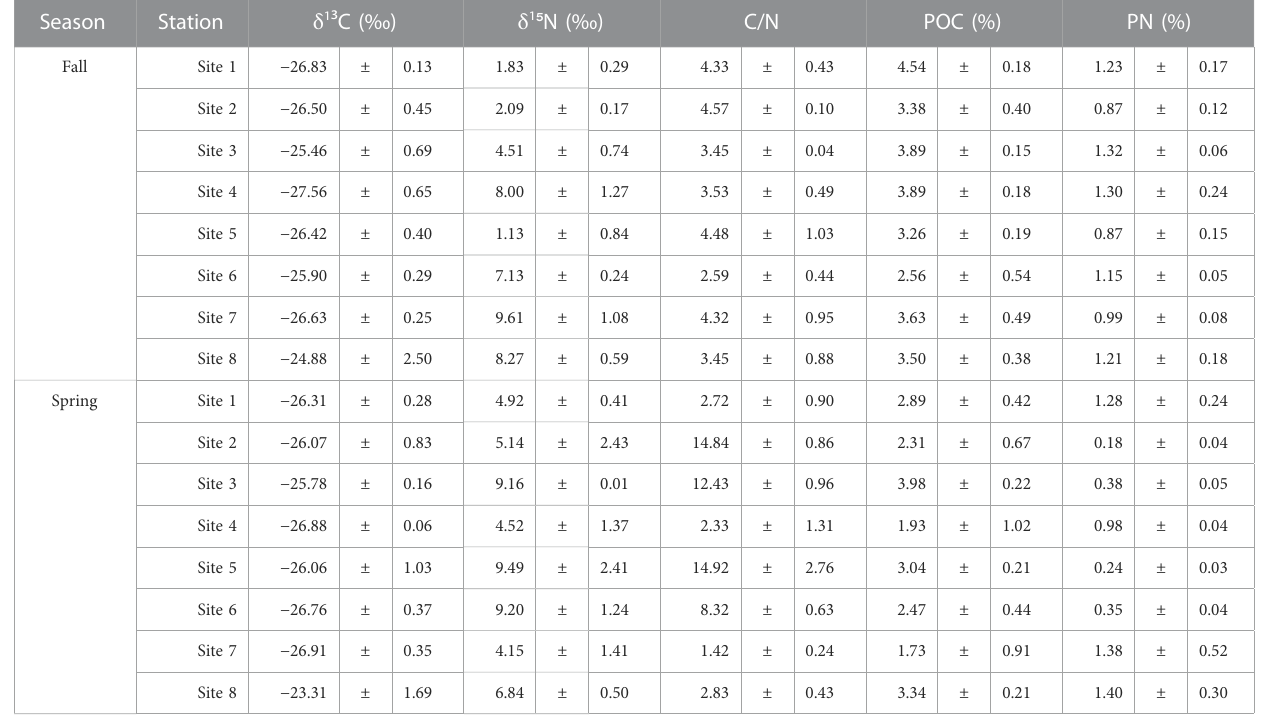
TABLE 2 Elemental and isotopic composition of POM from the Iyidere River to the Black Sea coast during the fall and spring seasons. Season Station δ 1 ³C ( ‰ ) δ 1 ⁵ N ( ‰